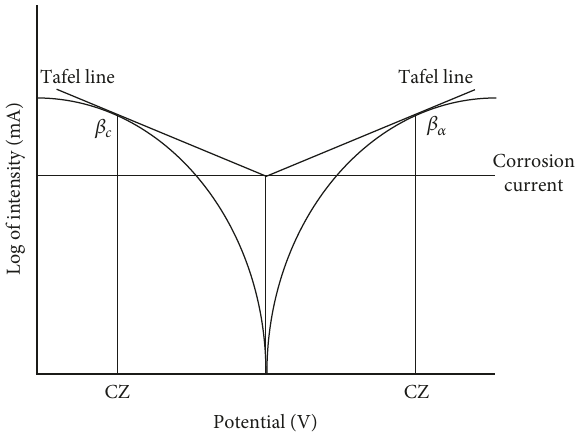
Figure 2: The curve between potential against log of current